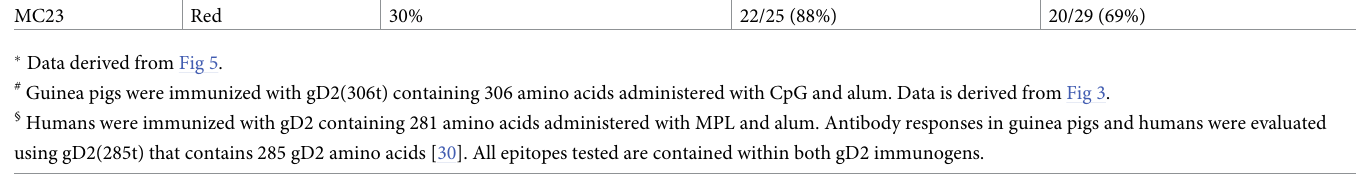
PLOS Pathogens| https://doi.org/10.1371/journal.ppat.1007095 May 23,